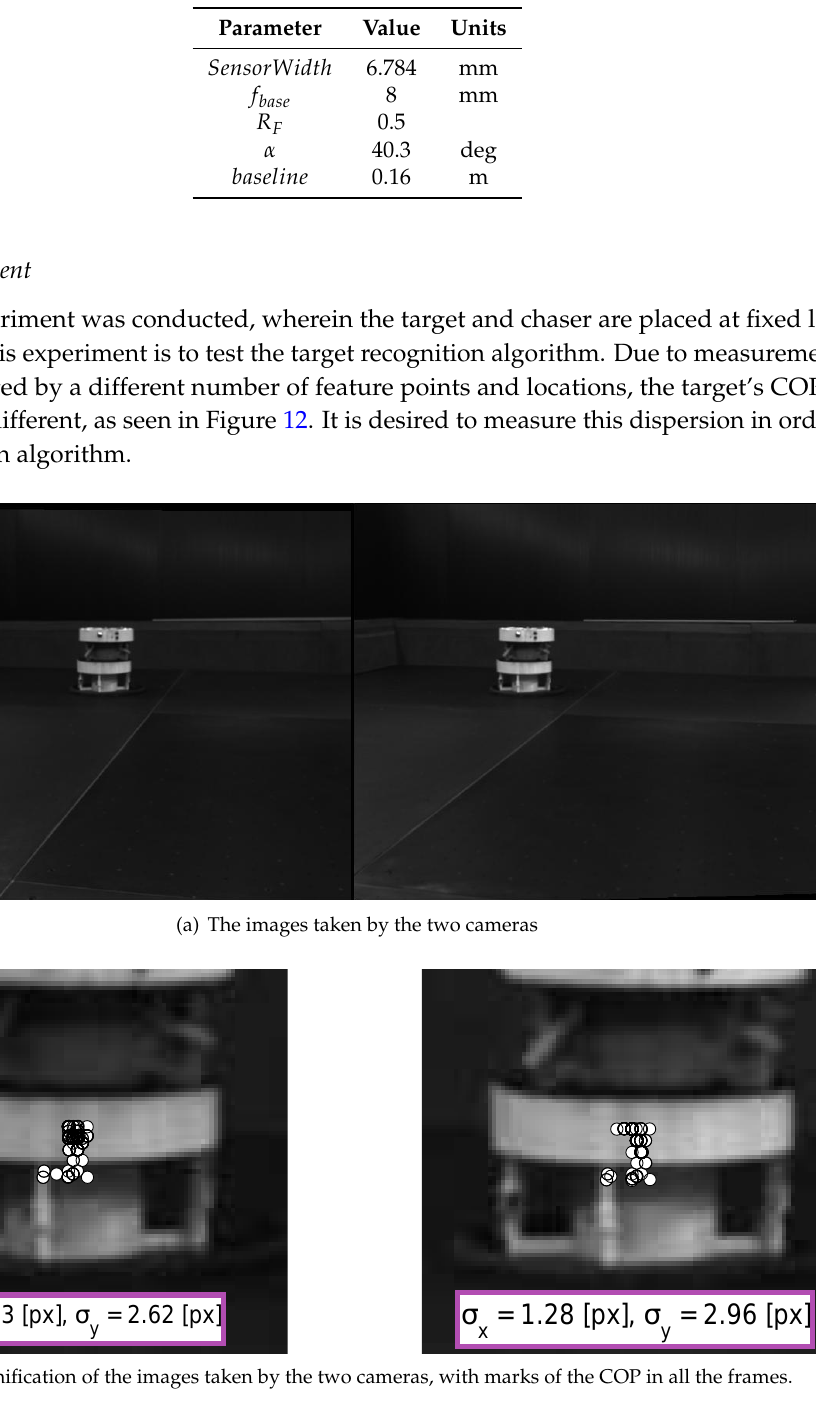
Figure 12. The images taken by the two cameras, with a statistical analysis of the COP